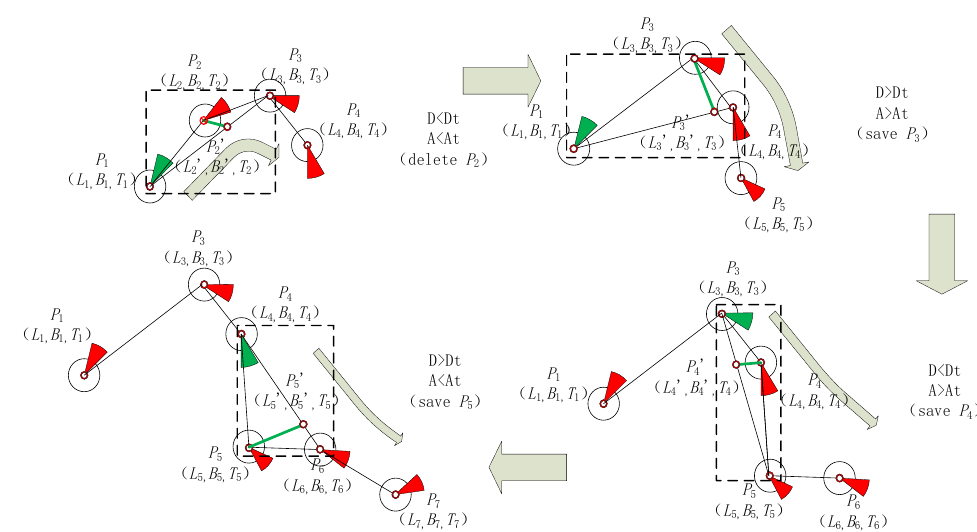
Figure 6. Schematic of the proposed improved sliding window algorithm.